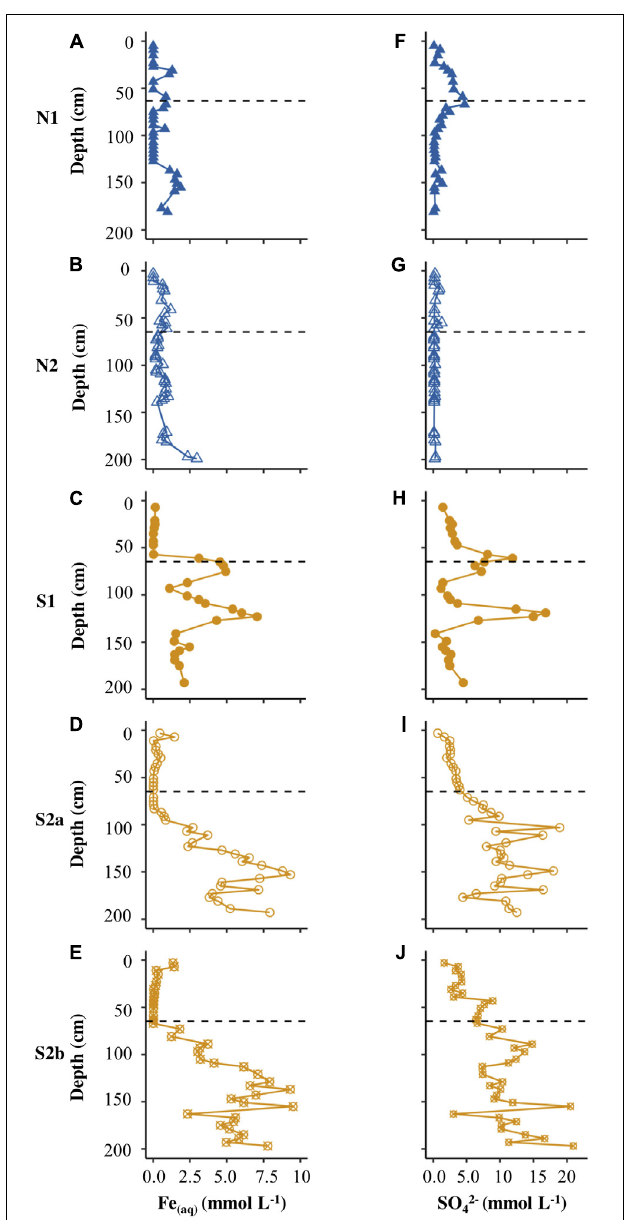
FIGURE 4 | Depth profiles of calcium (A–E) and magnesium (F–J) for N1, N2, S1, S2a, and S2b. The horizontal dashed line on each plot represents the base of the active layer in